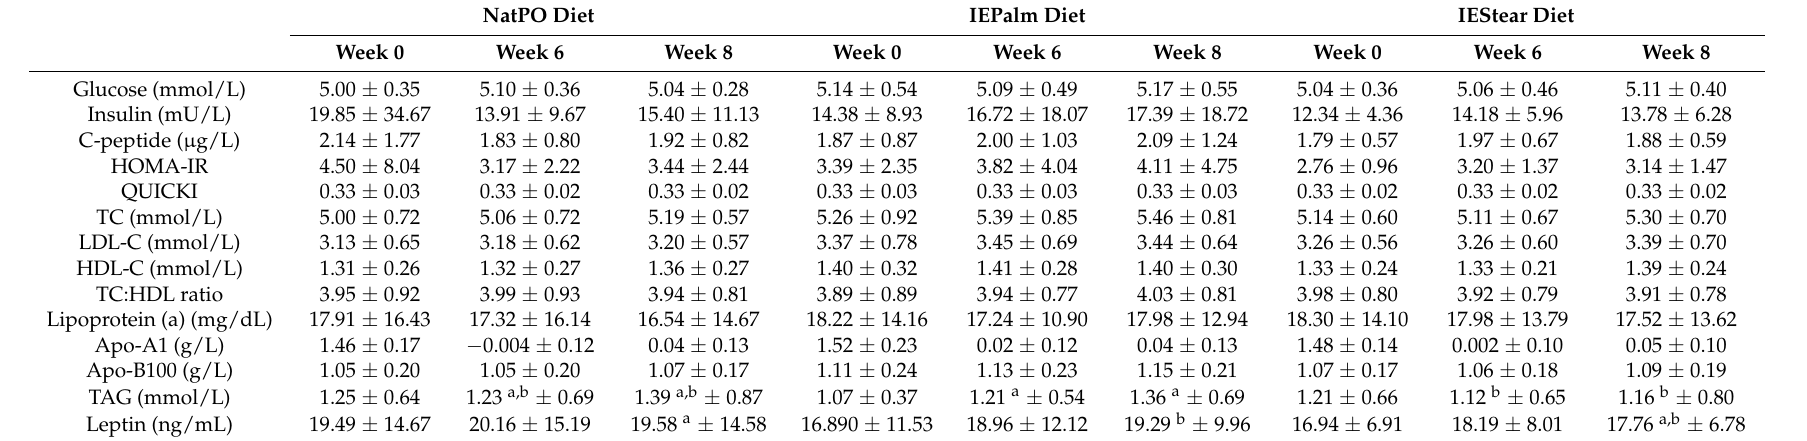
Table 4. Means ± SDs of surrogate markers measured at week 0, week 6 and week 8.